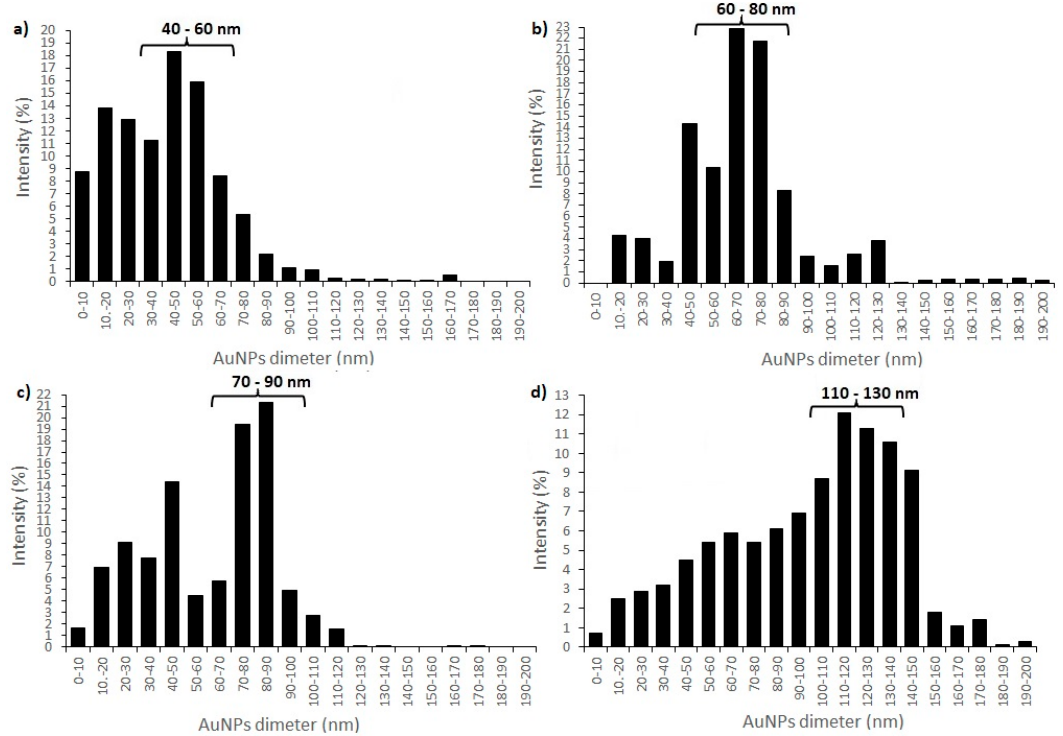
Figure 3. DLS size distributions of colloidal AuNPs: ( a ) AuCl_1; ( b ) AuCl_2; ( c ) AuAc_1 and ( d ) AuAc_2.